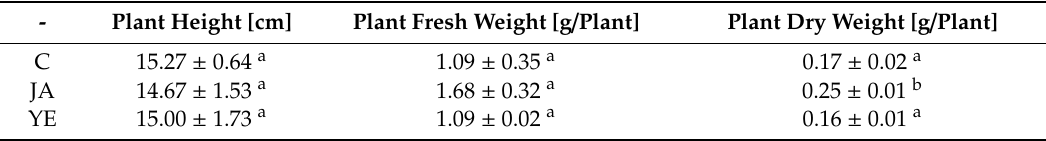
Table 1. Growth parameters of control and elicited with jasmonic acid and yeast extract lovage plants (36-day-old